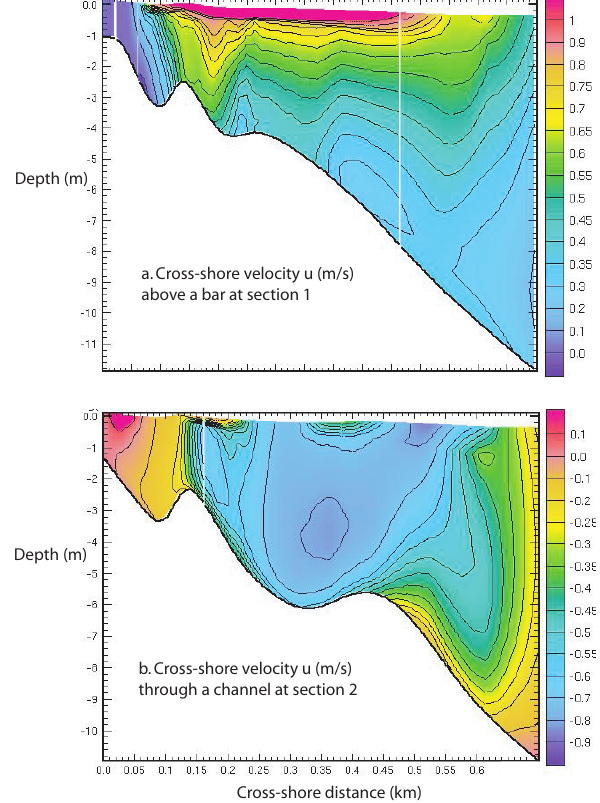
Fig. 16. Vertical sections of the cross-shore velocity (positive to- ward the shore) above a bar ( a , section 1) and through a channel ( b , section 2) during the rising stage of the storm. Positions of the sections are indicated in Fig. 15.